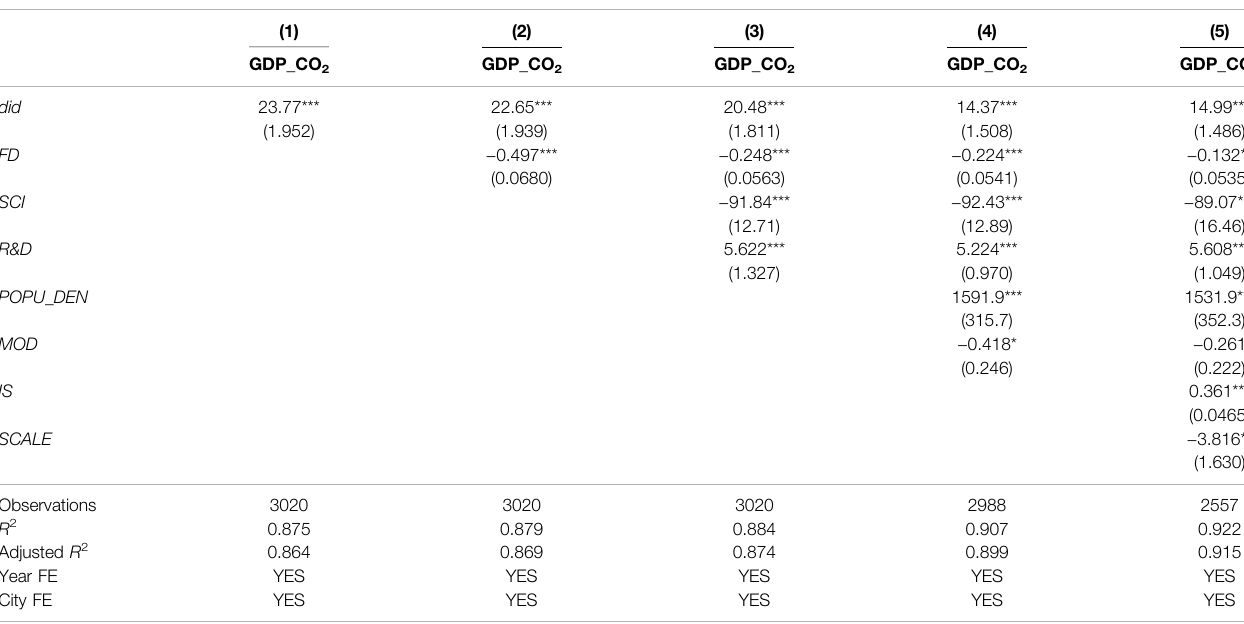
TABLE 5 | Results of GDP per unit carbon dioxide emission as the explanatory